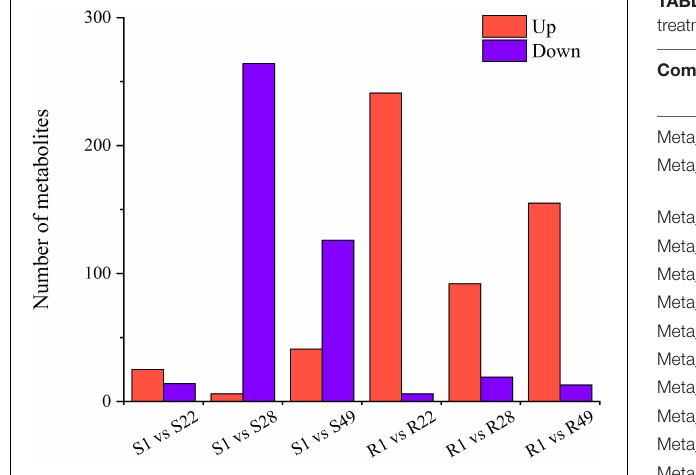
FIGURE 3 | Differential metabolites of S1 vs. S22, S1 vs. S28, S1 vs. S49, R1 vs. R22, R1 vs. R28, and R1 vs. R49. 1, Control; 22, Ri + Pf + Th; 28, Fo; 49, Ri + Pf + Th + Fo.